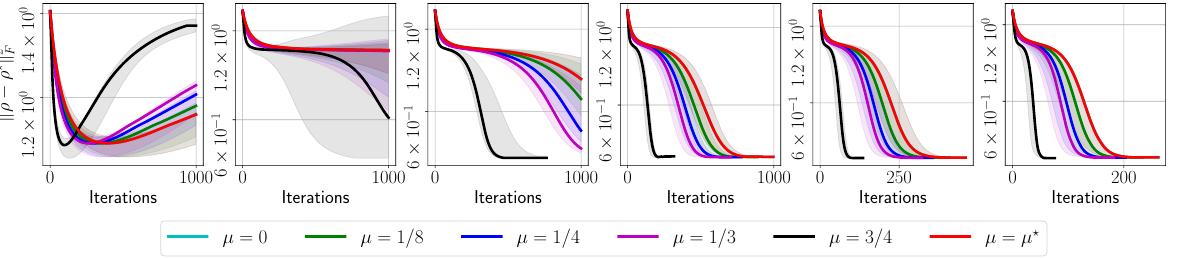
Figure A1. Target error list plots for reconstructing GHZ IBM Quantum system experiments.